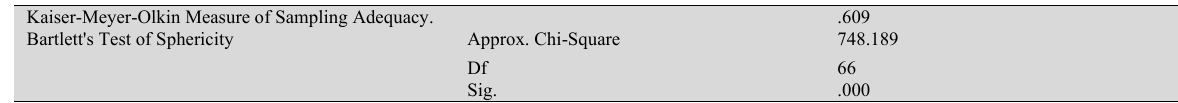
Table 4 KMO and Bartlett's Test Kaiser-Meyer-Olkin Measure of Sampling